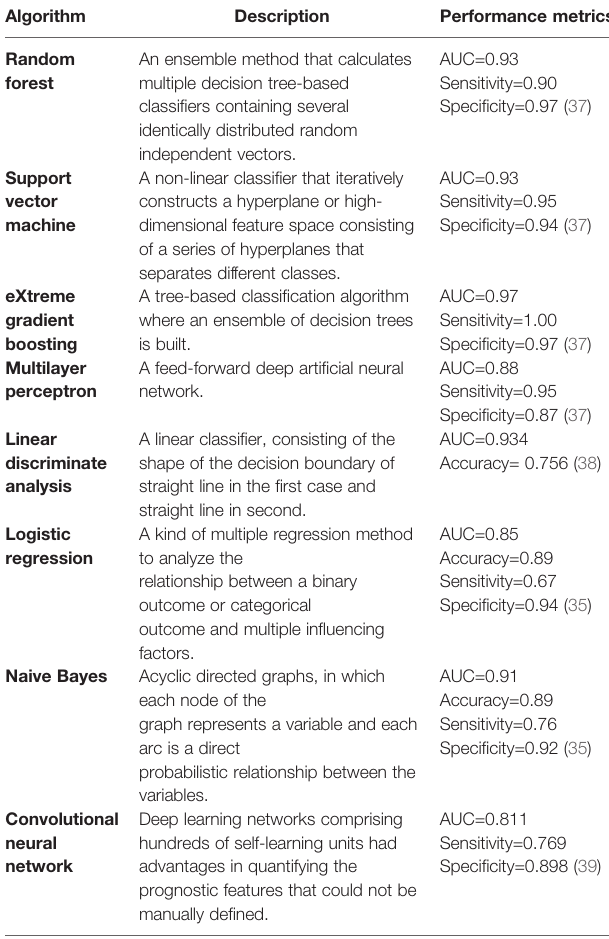
TABLE 3 | Summary of commonly used algorithms along with their performance